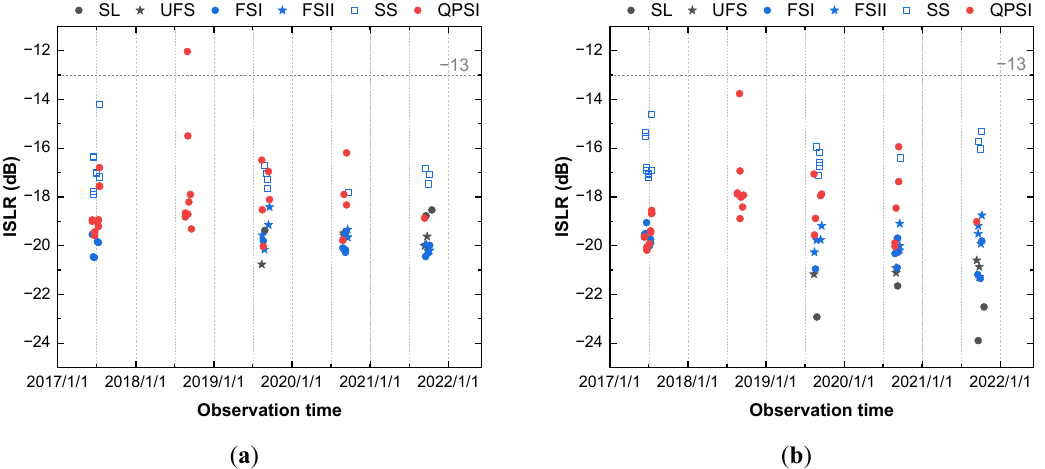
Figure 8. GaoFen-3’s ISLR estimation in Inner Mongolia with CR datasets acquired from June 2017 to October 2021. ( a ) Results in the range direction; and ( b ) the azimuth results.